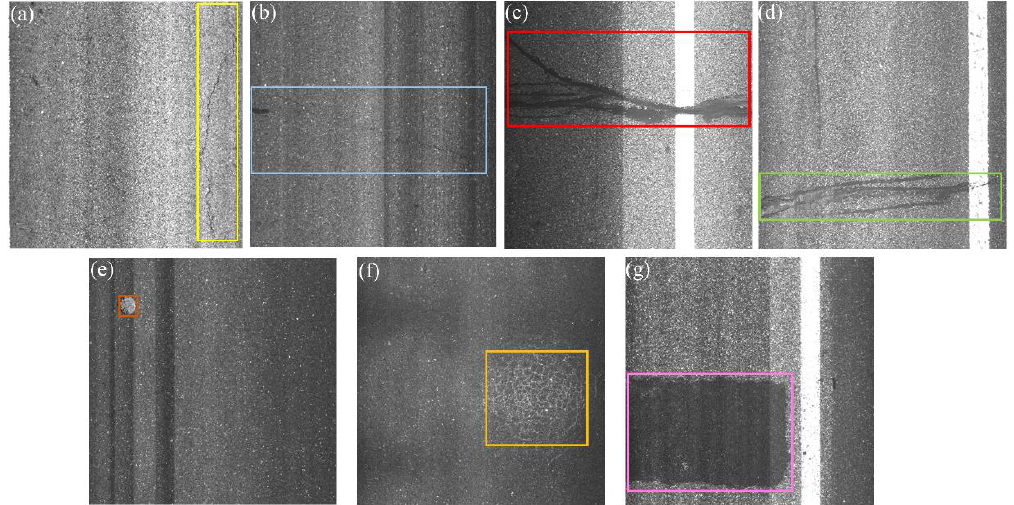
Figure 5. HL2019 dataset. ( a ) Longitudinal crack (LC). ( b ) Transverse crack (TC). ( c ) Repair (P). ( d ) Poor repair (PR). ( e ) Pothole (P). ( f ) Crazing (C). ( g ) Block repair (BR).